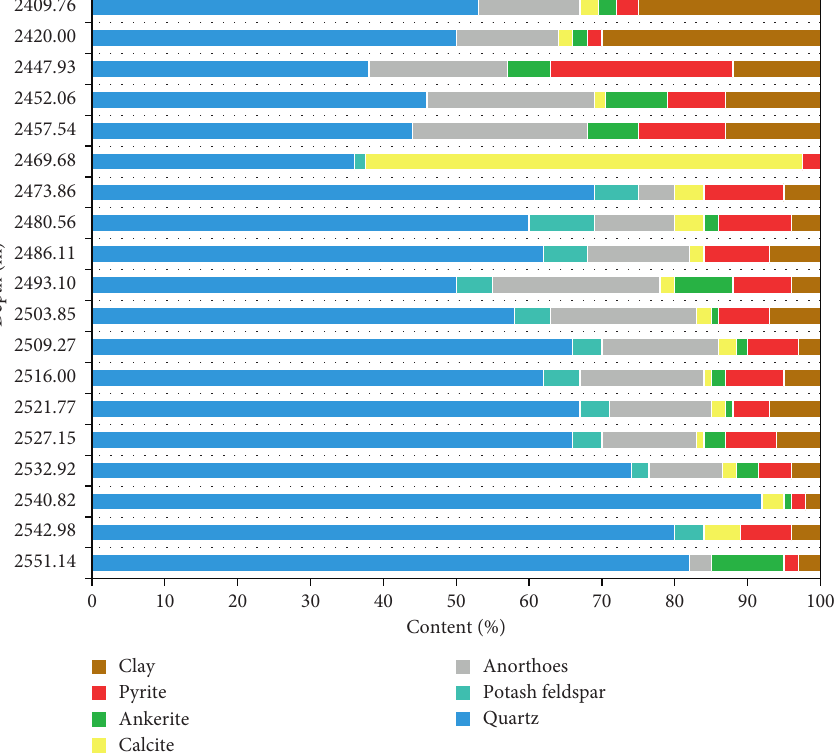
Figure 5: Distribution map of shale mineral content.